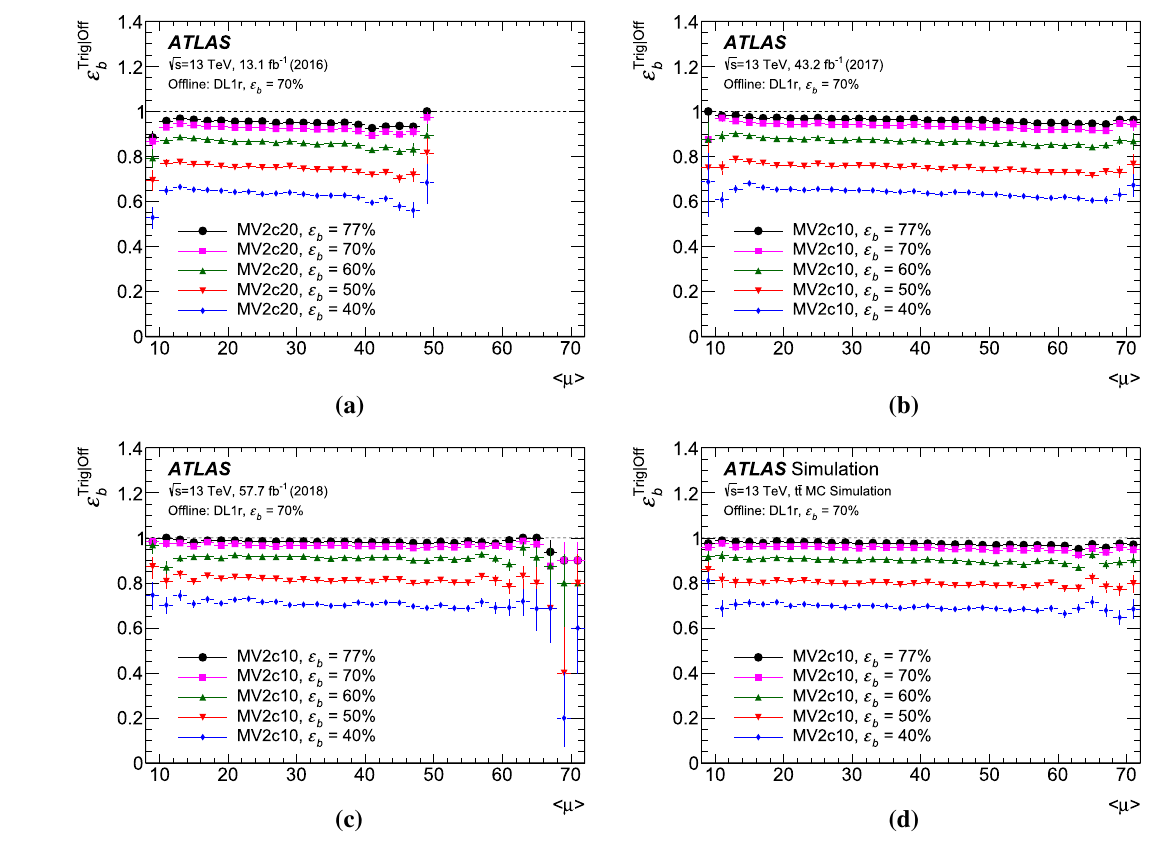
| Off online are shown in combination with offline jets that are required to , for data taken b pass the 70% efficiency working point of the DL1r algorithm. Only statistical uncertainties are